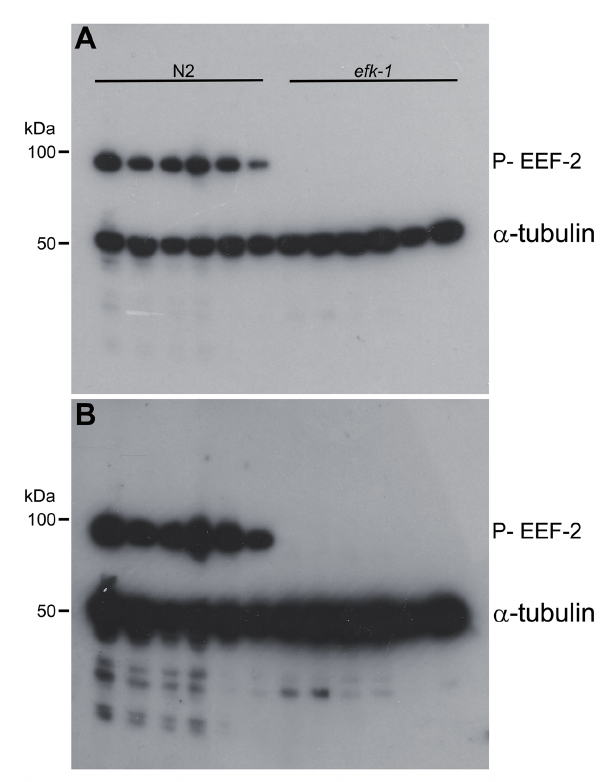
Figure 3. Phospho-eEF2 antibody and α -tubulin antibodies can be used simultaneously to C. elegans target detection. Western blot showing that phospho-eEF2 and α -tubulin antibodies can be incubated and developed simultaneously. efk-1 knockout worms were used as negative control to phospho-EEF-2 detection showed in wild-type worms (N2). A ) Western blot short exposure (1 min). B ) Western blot short exposure (3 min). Indicated molecular weight based on Precision Plus Protein™ Dual Color Standard